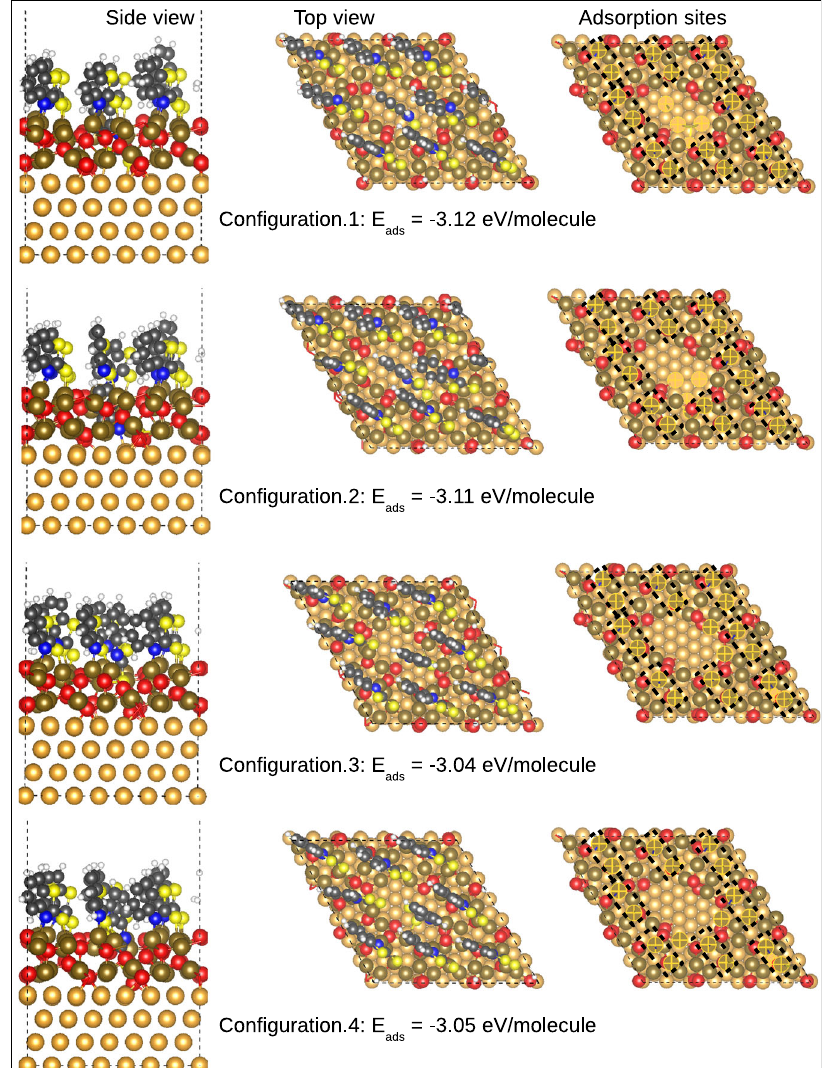
Fig. 6 Con fi gurations from 1 to 4 of MBT° form adsorbed on the partially oxide-covered copper surface. Illustration of side and top views and different adsorption sites on partially oxide-covered Comparison of the interaction of MBT with the oxide-free copper surface reveals that MBT adsorbs more strongly on the fully oxidized copper surface 62 and on the partially oxidized copper surface than on the metal surface. Vernack et al. 51 reported an adsorption-energy value of − 1.40 eV/molecule for the thione species on the Cu(111) surface at a coverage of 3.9 molecule/nm 2 , where the molecules are oriented via -S -S toward the metal surface and sit on hollow and bridge sites. Geng et al. 69 reported that the adsorption of benzene thiolate on the fcc-bridge site of the (111) surface of metals, including Cu(111), is stronger via the S atom, with an adsorption energy of − 2.26 eV/molecule Adsorption on the oxide edges . For MBTH adsorbed at the edges of the oxide hole, as shown by the snapshot in Fig. 5c, the most stable con fi guration corresponds to the dissociative adsorption instead of intact molecular adsorption. We observed the proton transfer from the NH group to the oxygen localized on the oxide edges and this time the molecule binds via N..HO (cid:1) up H-bonding instead of NH...O up H-bonding observed on the oxide surface. The distance N...HO is 1.67 Å . The molecule also